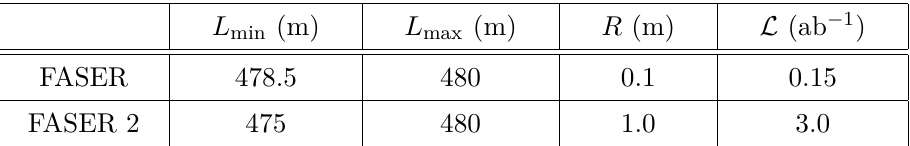
Table 1 . Dimension of the FASER detector and integrated luminosity used in this study. L min and L max are the distance to the front and rear end of the FASER detector from the IP, respectively. R is detector radius, respectively. L is the integrated